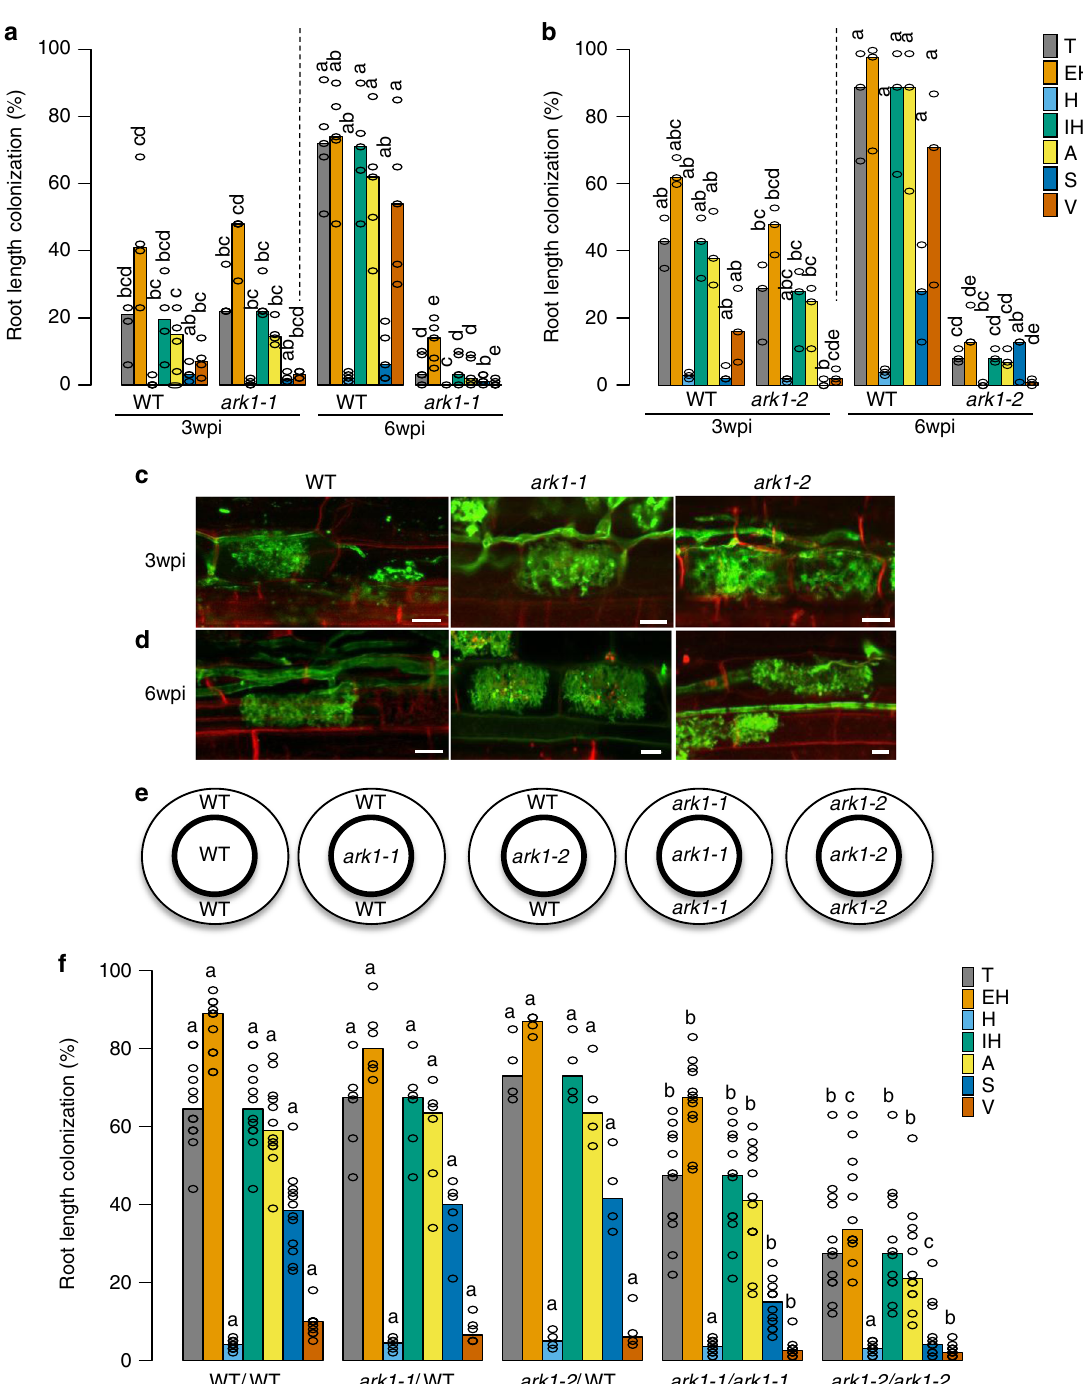
Fig. 3 ark1 mutants show reduced R. irregularis colonization after prolonged cocultivation. Percentage (%) root length colonized in wild-type and ark1-1 ( a ) and ark1-2 ( b ) mutant alleles at 3 weeks post inoculation (3 wpi) and 6 wpi. c , d Wheat Germ Agglutinin (WGA, green) and propidium iodide counter- stained plant cell walls (red) of WT, ark1-1 , and ark1-2 at 3 wpi and 6 wpi, Scale bar 10 μ m. Representative images of three roots from at least three plants are provided. e Nurse plant experimental design and f abundance of fungal structures (%) in nurse plant-inoculated WT, ark1-1 , and ark1-2 as indicated in ( e ) at 6 wpi; T total colonization, EH extra-radical hyphae, H hyphopodia, IH intra-radical hyphae, A, arbuscules, S spores, V vesicles. For statistical analysis Kruskal − Wallis tests with the Holm adjustment method were performed using the agricolae package and selecting the option for “ treatment groups formation ” with P value set at ≤ 0.05. Bars show median levels while the letters above each bar indicate colonization values that were not signi fi cantly different in the post hoc pairwise